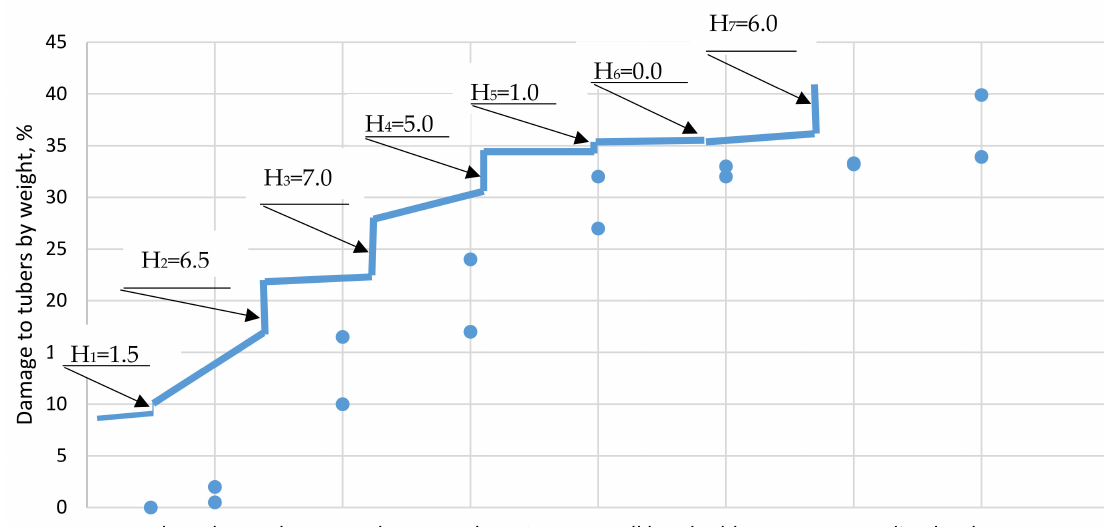
Figure 5. Damage to potato tubers on the working bodies of the